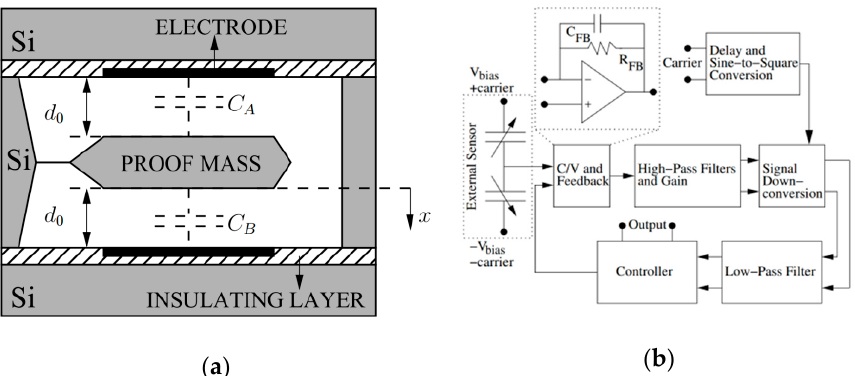
Figure 11. Schematic diagrams of the MEMS accelerometer and its closed-loop system developed by Aaltonen et al. at Helsinki University of Technology [9,10]: ( a ) schematic of the MEMS accelerometer; ( b ) block diagram of the closed-loop control system.